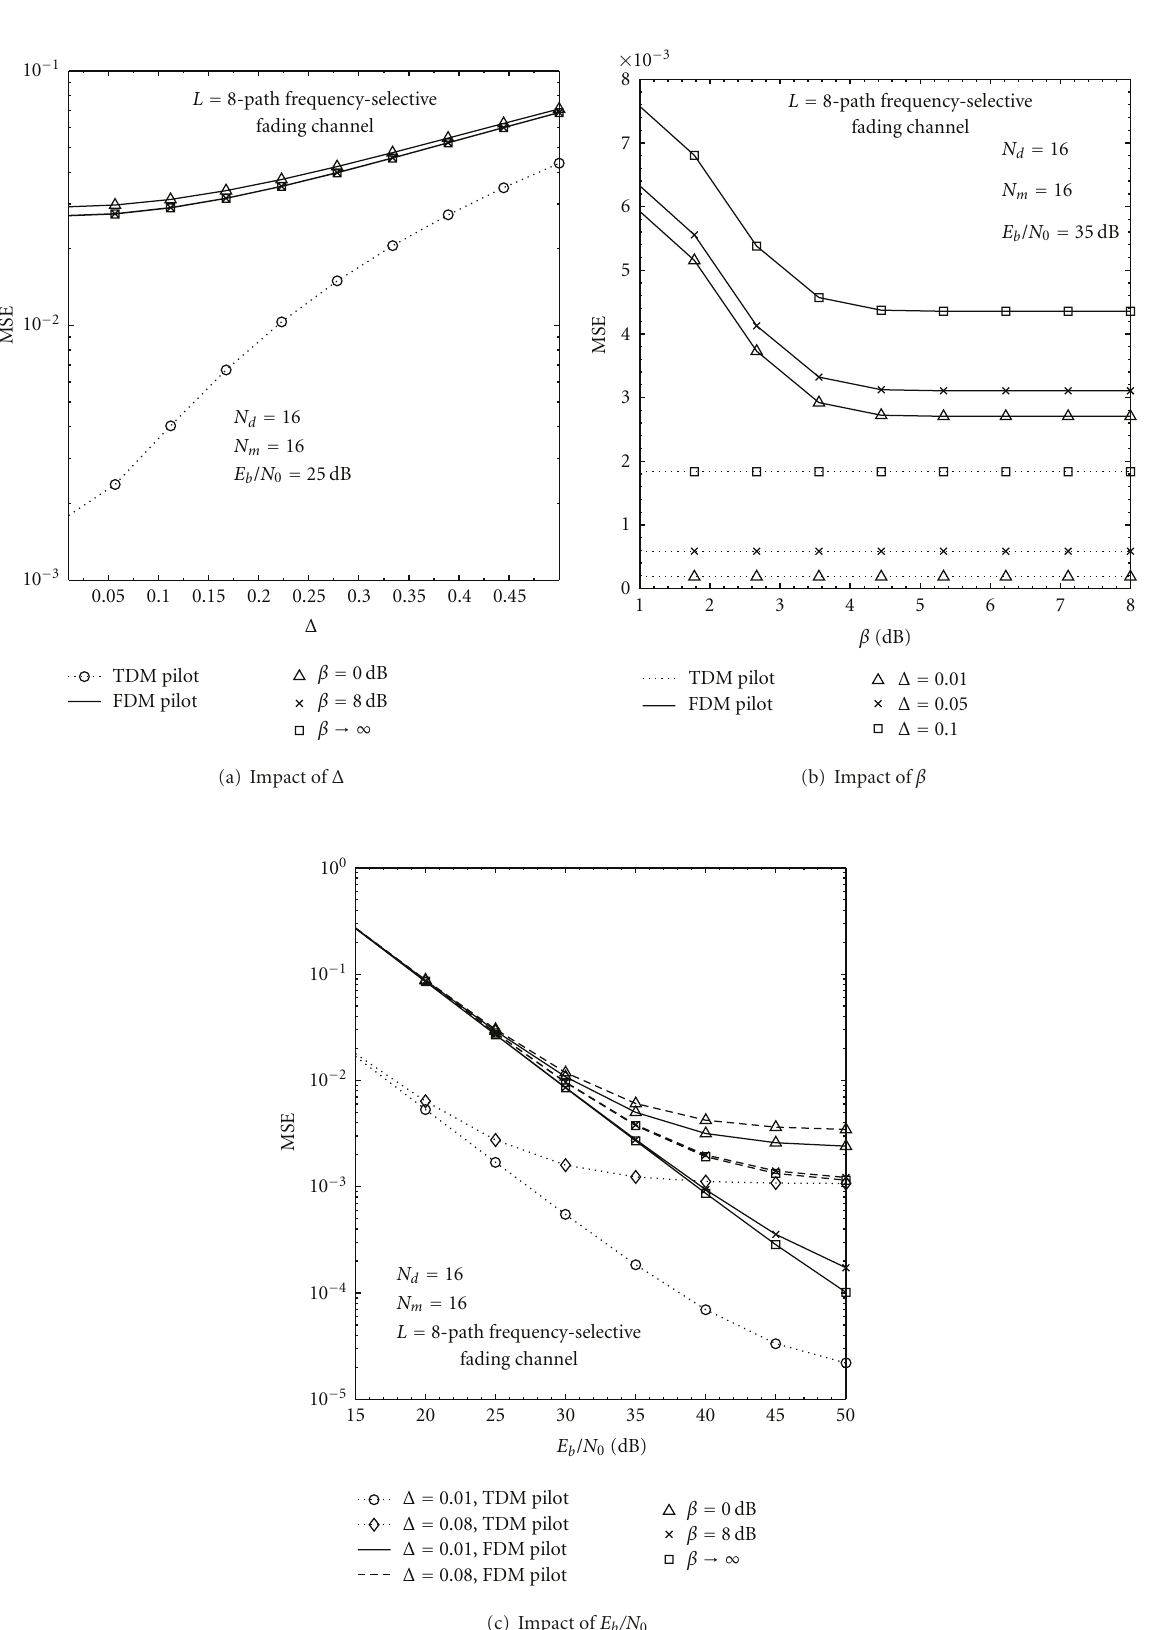
Figure 9: MSE of the channel